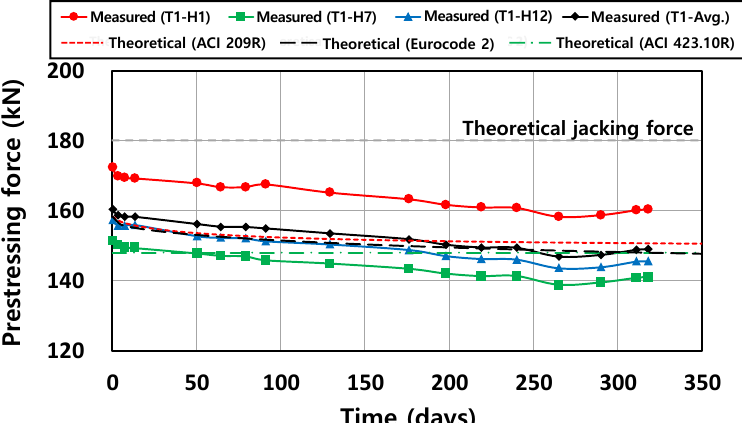
Figure 8. PFs at mid-span in the full-scale specimen (T1-H1, H7, and H12).